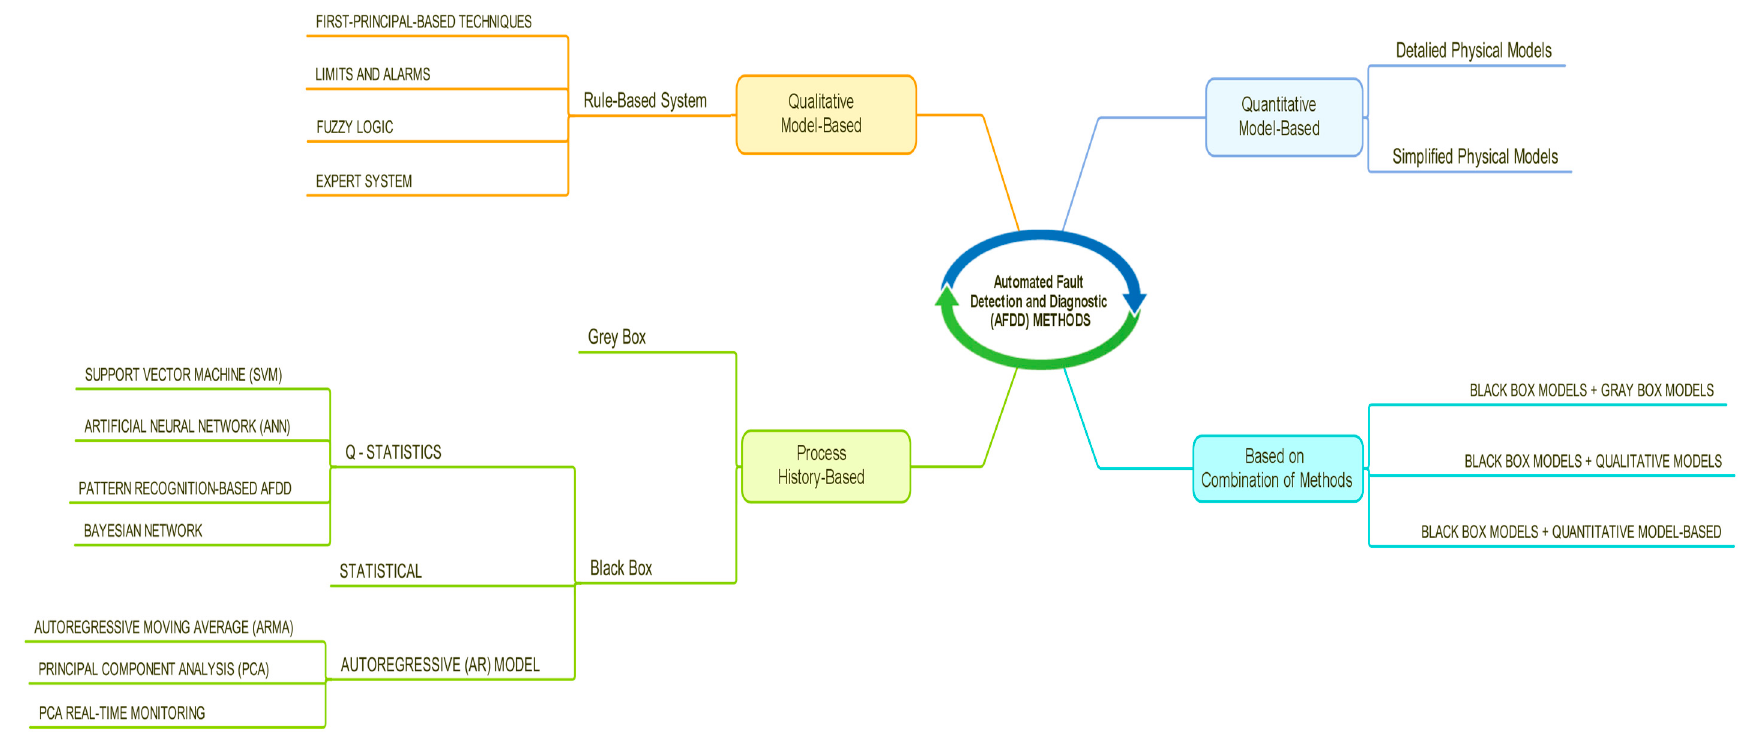
Figure 2. Classification scheme for AFDD methods based on previous research [60,61].